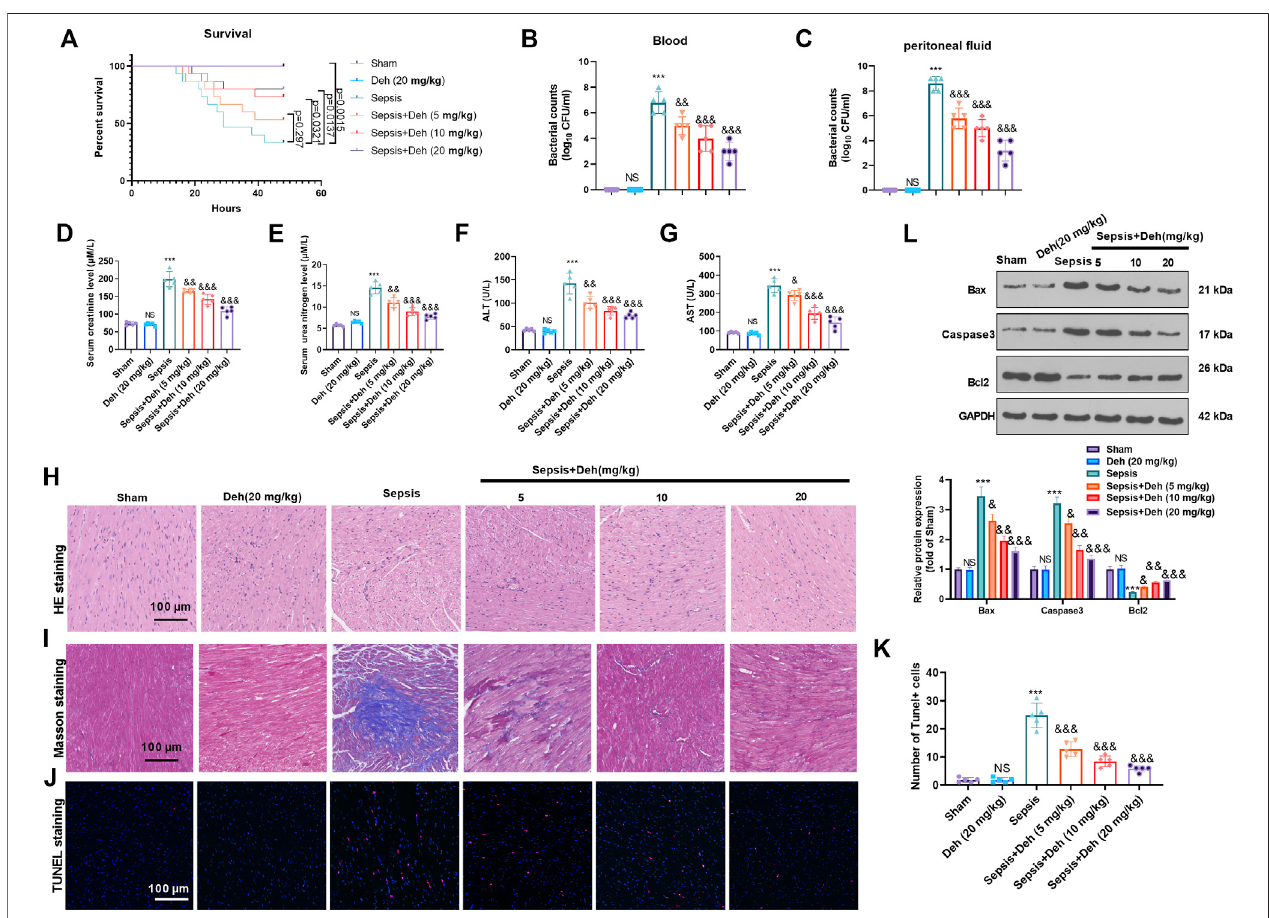
FIGURE 1 | Deh attenuated sepsis-mediated myocardial damage. The in-vivo model of sepsis in C57BL/6 mice was induced by intraperitoneal injection of Escherichia coli ( E. coli ). Deh (5 – 20 mg/kg body weight) was administered into the mice via intraperitoneal injection. (A) The survival (within 48 h after modeling) of mice wasanalyzed via theKaplanMeiermethod. (B,C) Thebacterialcountsinthecollectedperitoneallavage fl uidandserumwerecalculated. (D – G) .Thelevelsofcreatinine, urea nitrogen, aspartate aminotransferase (AST), and alanine aminotransferase (ALT) in the supernatant of peritoneal lavage fl uid and serum were measured using an automatic biochemical analyzer. (H, I) HE staining and Masson staining were used to detect myocardial injury in different groups of mice. (J, K) TUNEL-labeled apoptosiscells were detected using the TUNEL-detection kit. Thenumber ofTUNEL-positive cellwere counted. (L) Westernblotwascarried outtoexaminetheprotein levelsofBax,Caspase3andBcl2inthemyocardialtissues.NS p > 0.05,*** p < 0.001(vs.Shamgroup);& p < 0.05,&& p < 0.01,&&& p < 0.001(vs.Sepsisgroup).N (cid:1) 5.